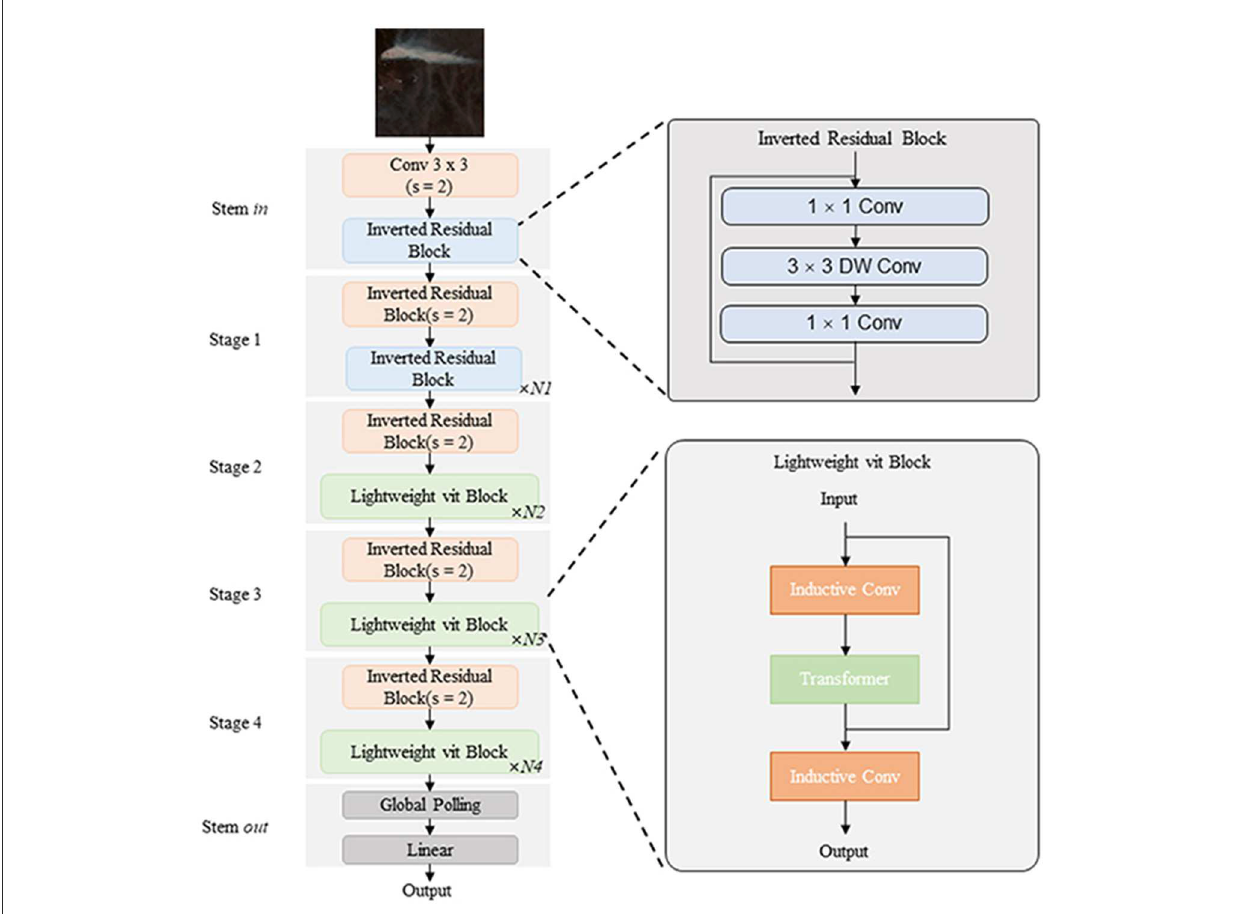
FIGURE3 The network structure of the proposed SR-Net model. In this figure, “Conv” means convolution, “s” means stride, “Lightweight vit” means Lightweight Vision Transformer, and “Inductive Conv” means convolution layers used to perform inductive bias.